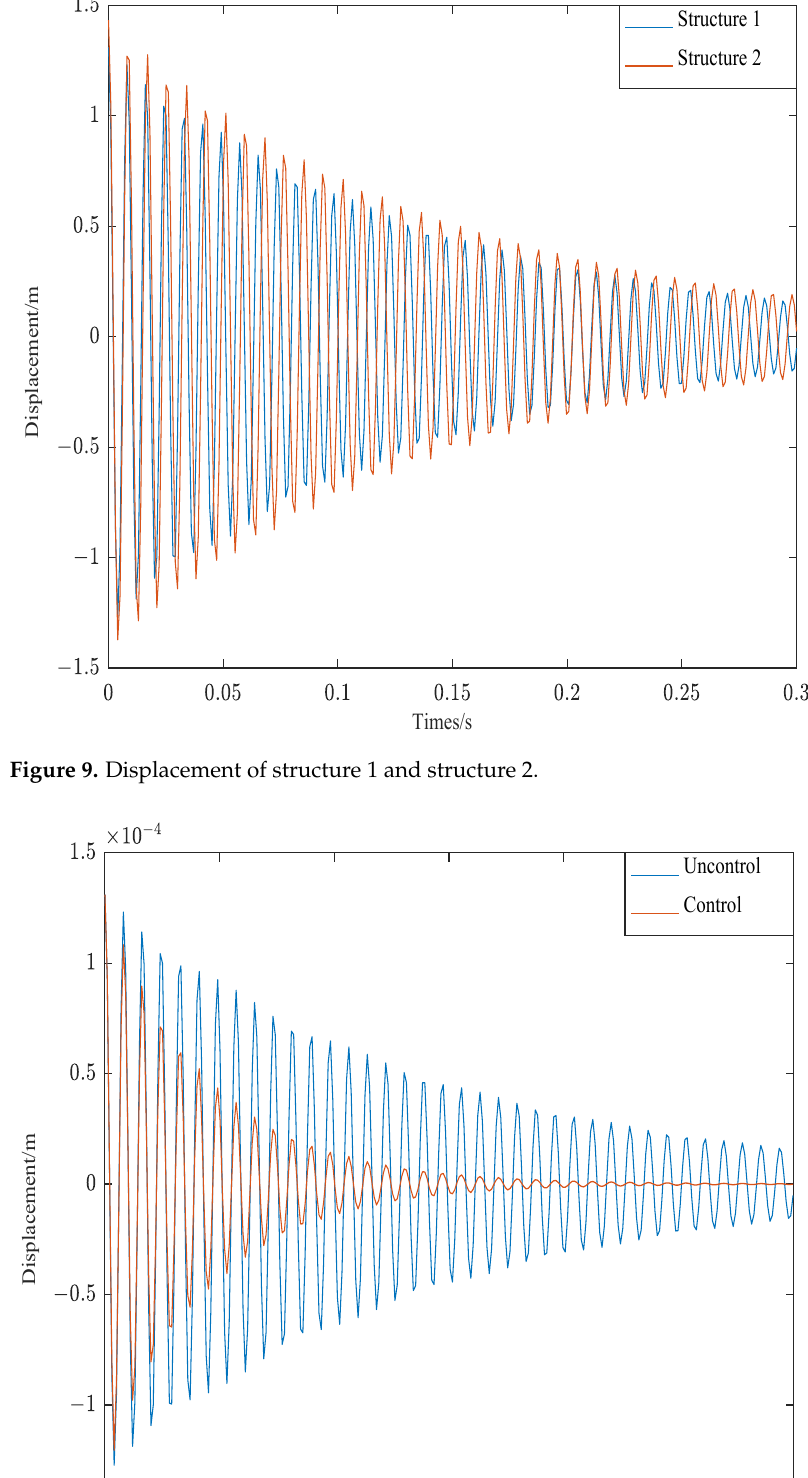
Figure 10. Response of structure 1.